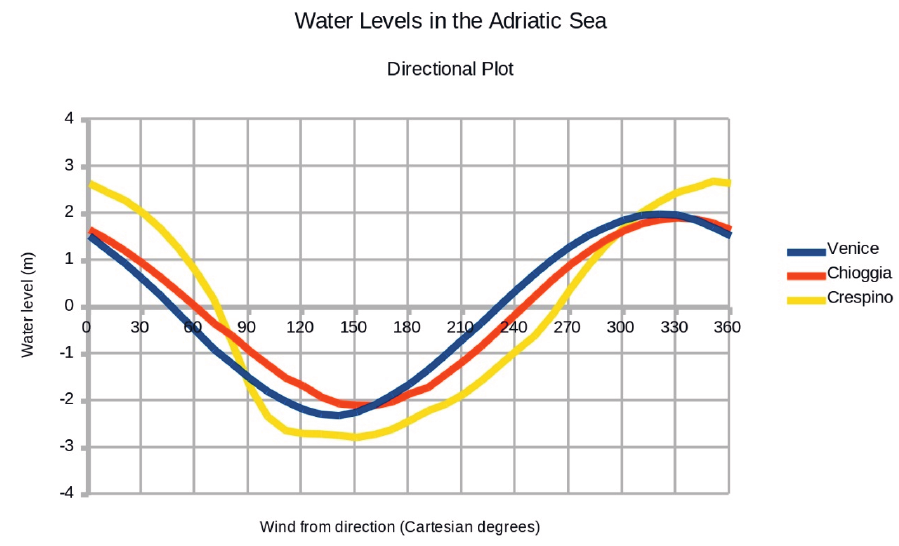
Figure 10. Directional plot for Venice, Chioggia, and Crespino.